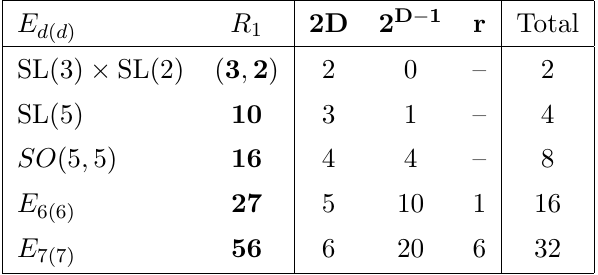
Table 1 . Number of Dirichlet directions in the decomposition of R 1 into O ( D; D )